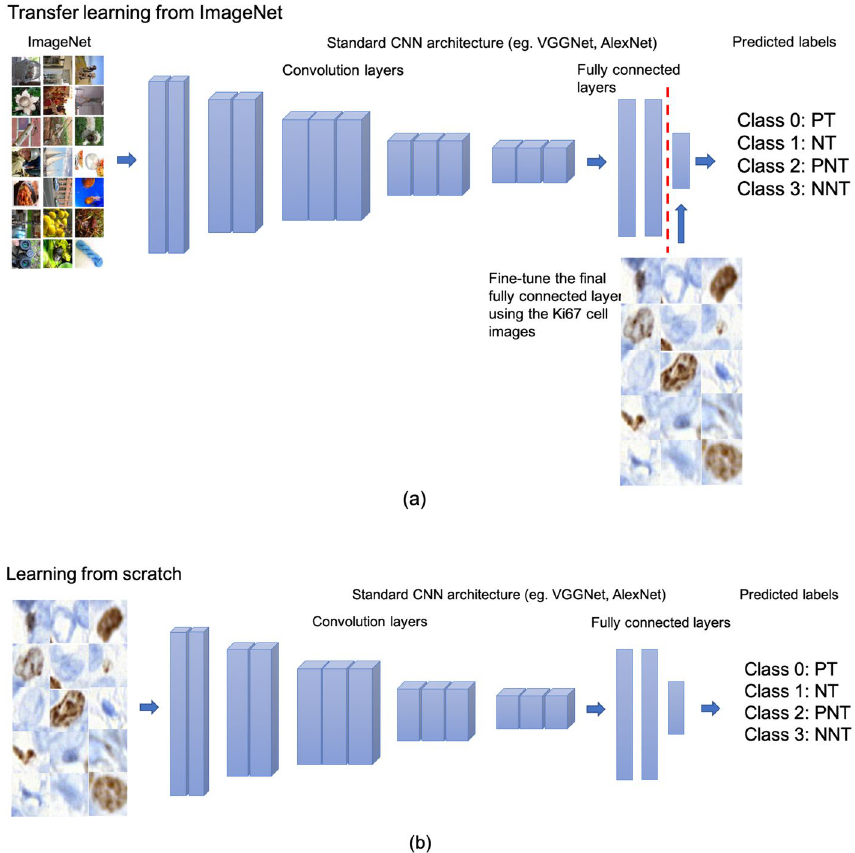
Figure 2. Illustrations of ( a ) transfer learning: a neural network is pretrained on ImageNet and subsequently trained on Ki67 cell images to perform 4 class classification ( b ) training from scratch: training the complete network from the first layer using the Ki67 cell images (PT: Positive Tumour; NT: Negative Tumour; PNT: Positive Non-Tumour; NNT: Negative